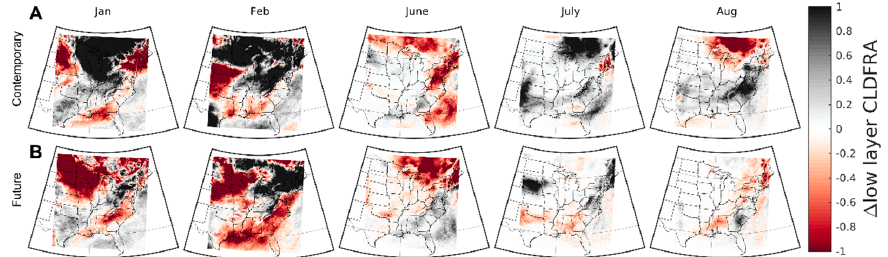
Figure 8. Difference in mean low level cloud cover (CLDFRA) (strong El Niño-weak La Niña) in the HadGEM2-WRF simulations for ( A ) the historical climate and ( B ) future climate scenarios, where low clouds are classified as z < 2000 m and where z is the height. Red indicates less cloud cover in the strong El Niño phase, while black indicates more cloud.